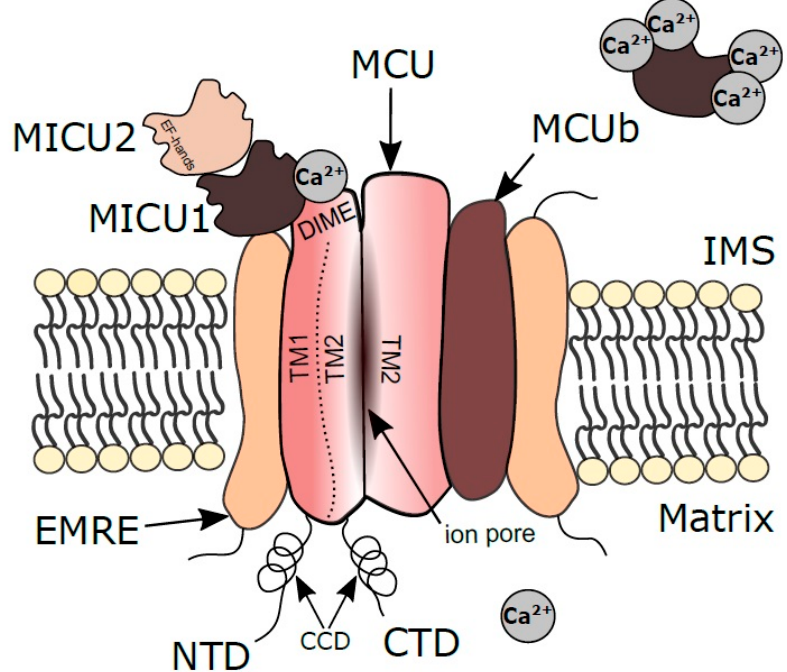
Figure 1. Scheme of mtCU structure. Mitochondrial calcium uniporter pore-forming subunit (MCU) and regulatory subunits are shown: MICU1 and 2—mitochondrial calcium uptake 1 and 2; MCUb—mitochondrial calcium uniporter dominant negative beta subunit; EMRE—essential MCU regulator. IMS—intermembrane space; NTD—N-terminal domain; CTD—C-terminal domain; TM1, TM2—two helices of the transmembrane domain; CCD—coiled coil domain; DIME—amino acids